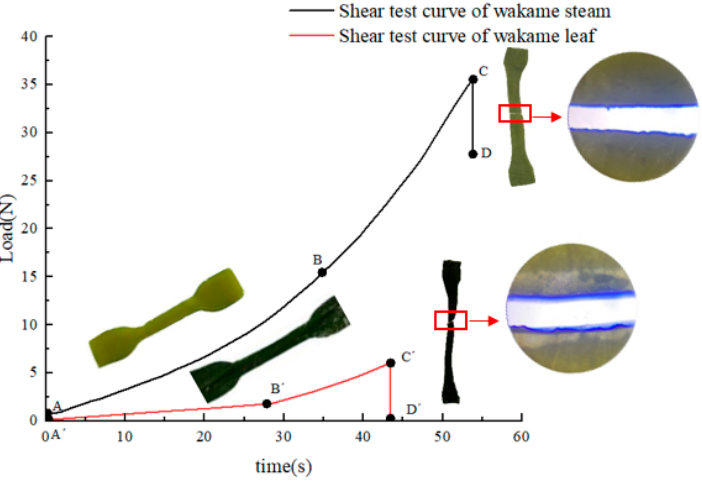
Figure 18. Shear-time curve of typical wakame stem and